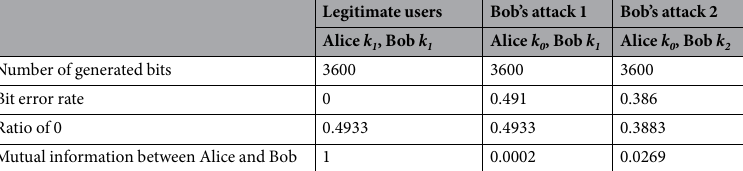
Table 1. Result of oblivious transfer at the bit generation rate of 110 kb/s. Left column: legitimate users (comparison between Alice’s key k